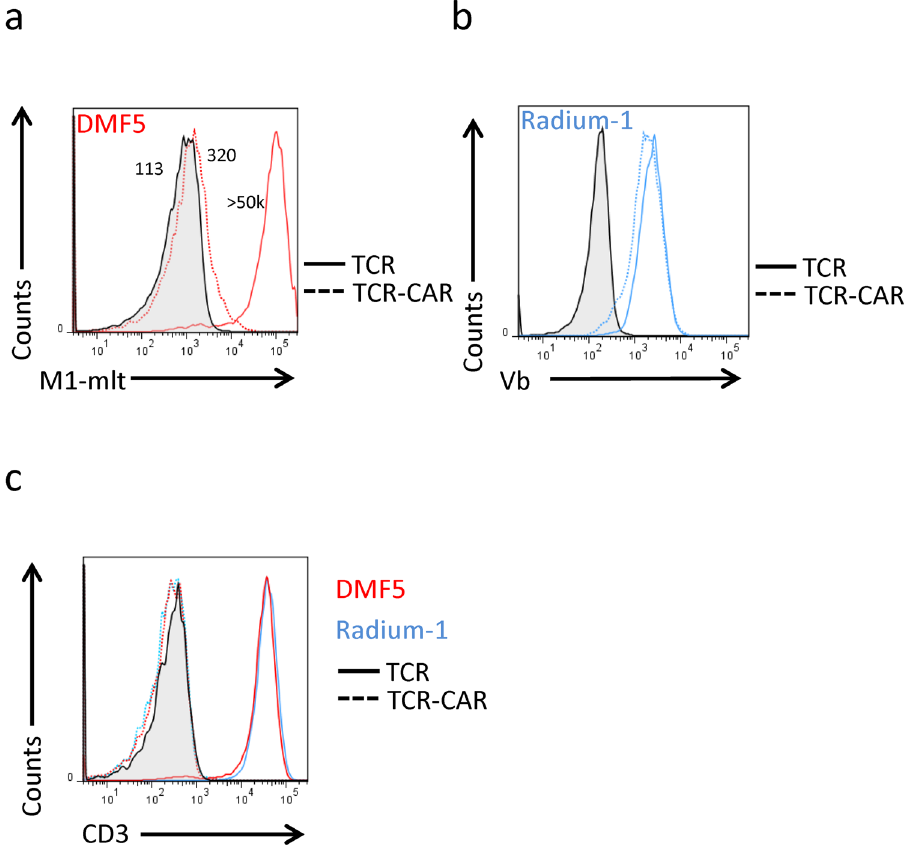
Figure 2. Membrane expression of TCR-CAR. ( a ) DMF5 TCR and TCR-CAR were expressed in J76 cell line. Forty-eight hours later, cells were stained with pMHC multimers of HLA-A2 in complex with MART-1 peptide (M1). Mock transduced cells (grey) were used as negative control, TCR and TCR-CAR (red, plain and dotted, respectively) are shown. Numbers specify MFI of the indicated staining. ( b ) Same as in ( a ) but Radium-1 TCR (plain) and TCR-CAR (dotted) were here expressed and J76 cells were stained with anti-Vb3 antibody (Vb). ( c ) The cells as in A (red) and B (blue) were stained with anti-CD3 antibody. As before, TCRs are shown as plain lines and TCR-CAR as dotted, and mock transduced is in grey. These are representative staining of similar experiments performed on different retroviral preparation of cells at least